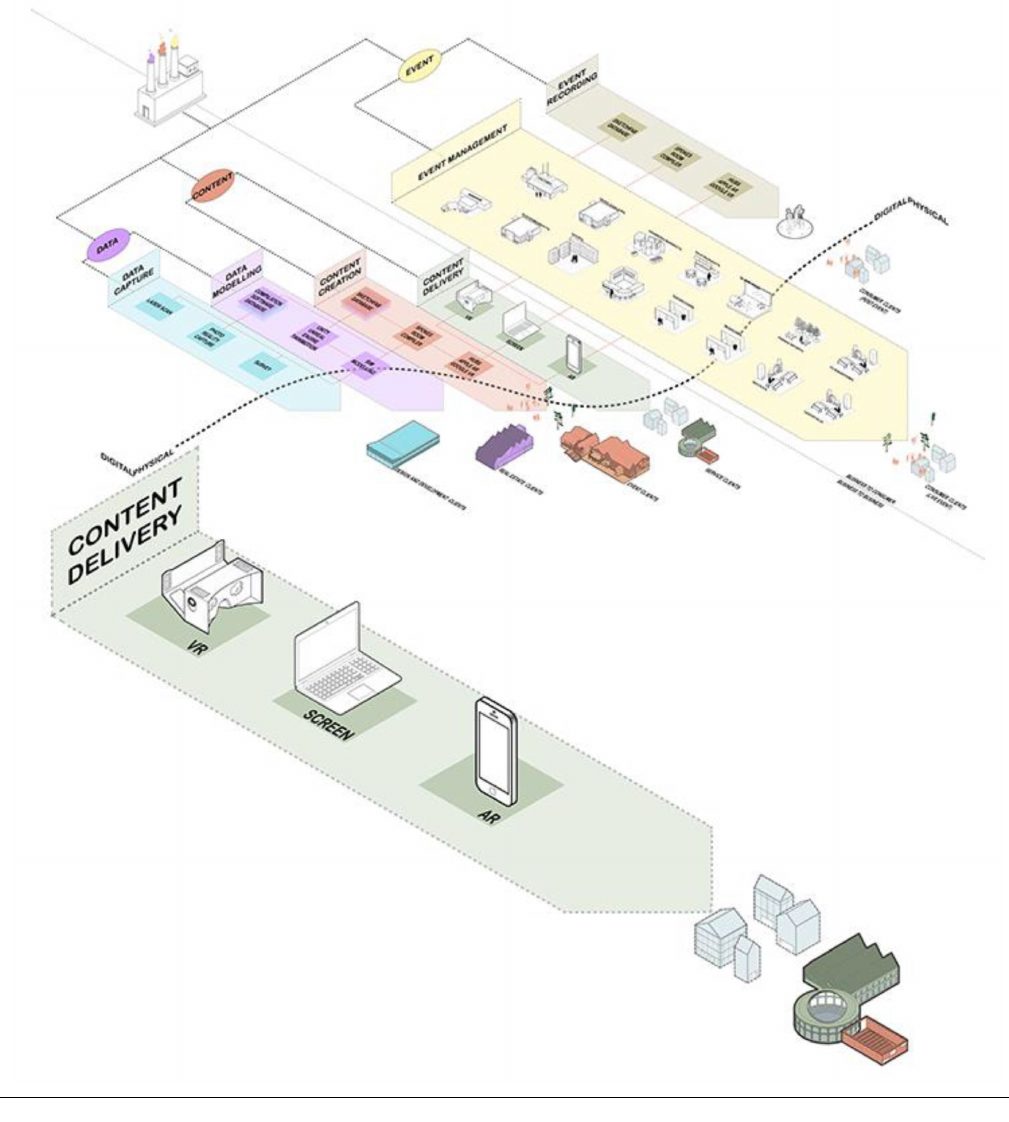
Figure 10. Conceptual overview of the layers of capturing, co-creation and experiencing through digital technologies (Source: Simon Kay-Jones,